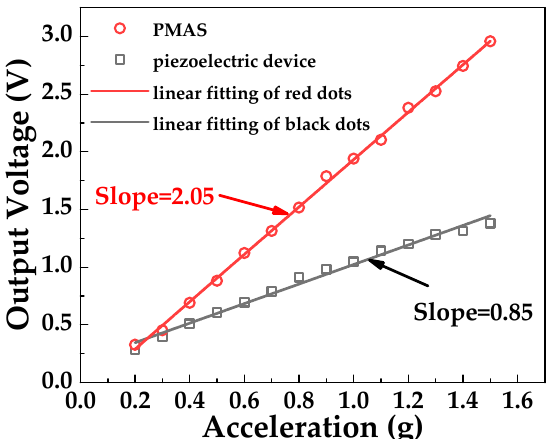
Figure 11. Relationship curves between output voltage and acceleration of PMAS and the piezoelectric beam.